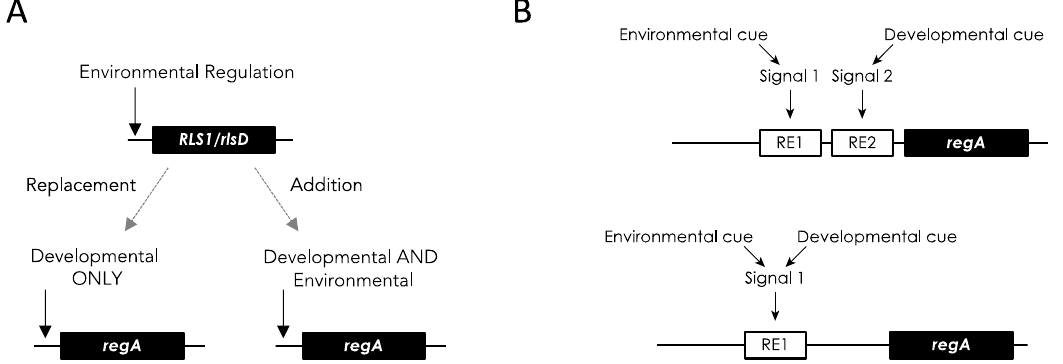
Figure 9. ( A ) Two potential scenarios envisioning the co-option of an ancestral environmentally reg- ulated RLS1 / rlsD -like gene into a developmentally regulated regA , involving either (i) the replace- ment of the ancestral environmental regulation or (ii) the addition of a new layer of regulation. ( B ) Two models to account for the observed dual regulation (environmental and developmental) of regA in V. carteri involving (i) the acquisition of a new signal transduction pathway and regulatory ele- ment (RE2) or (ii) the co-option of the environmentally induced intracellular signal and regulatory